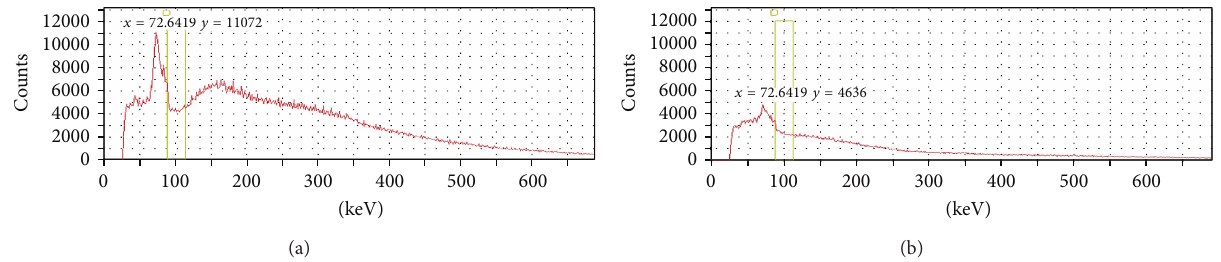
Figure 1: P-32 Bremsstrahlung energy spectra with (a) LEHR collimator and (b) MEGP collimator, obtained using a 37 MBq 32 P point source, in a glass vial, at a distance of 10cm from the collimator.